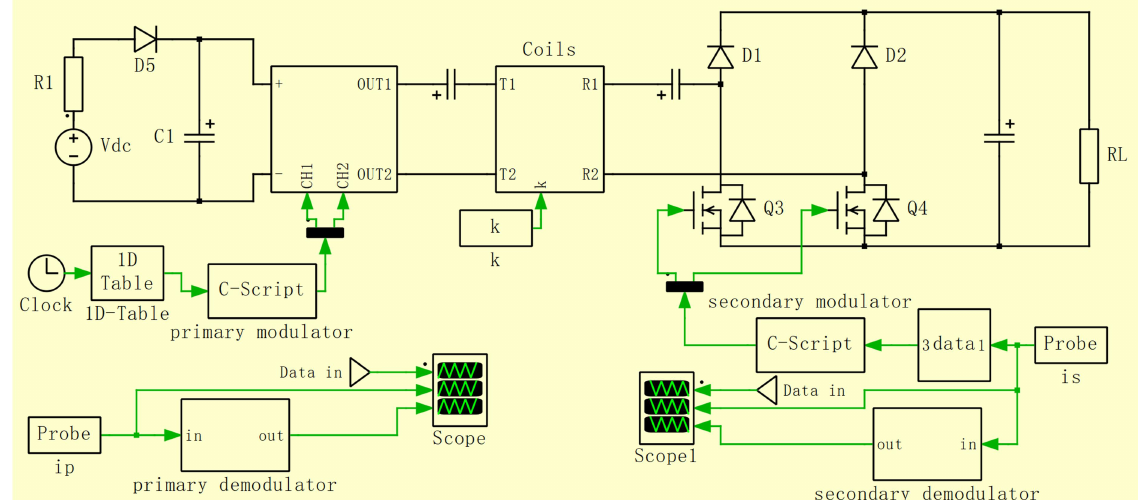
Figure 13. Overall diagram of simulation